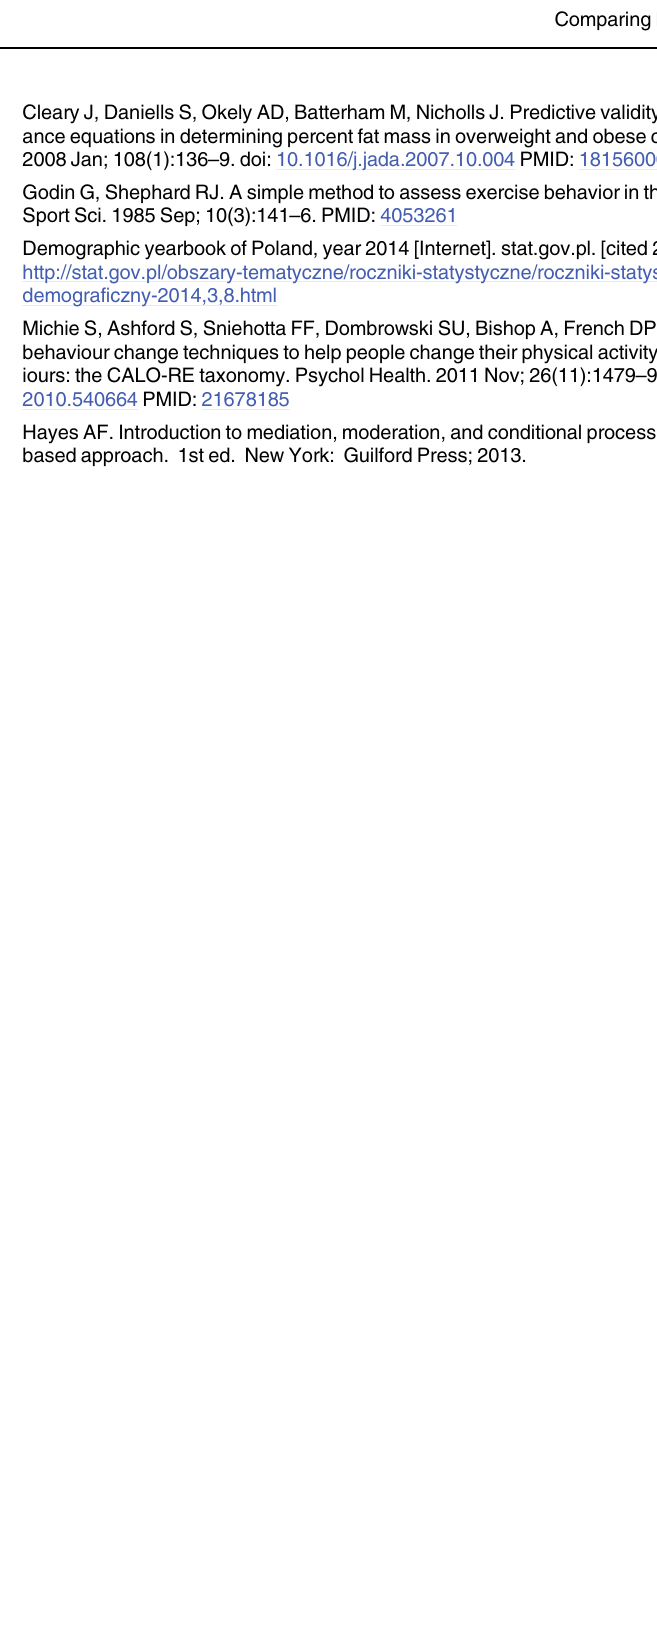
PLOS ONE | DOI:10.1371/journal.pone.0159125 July 13,